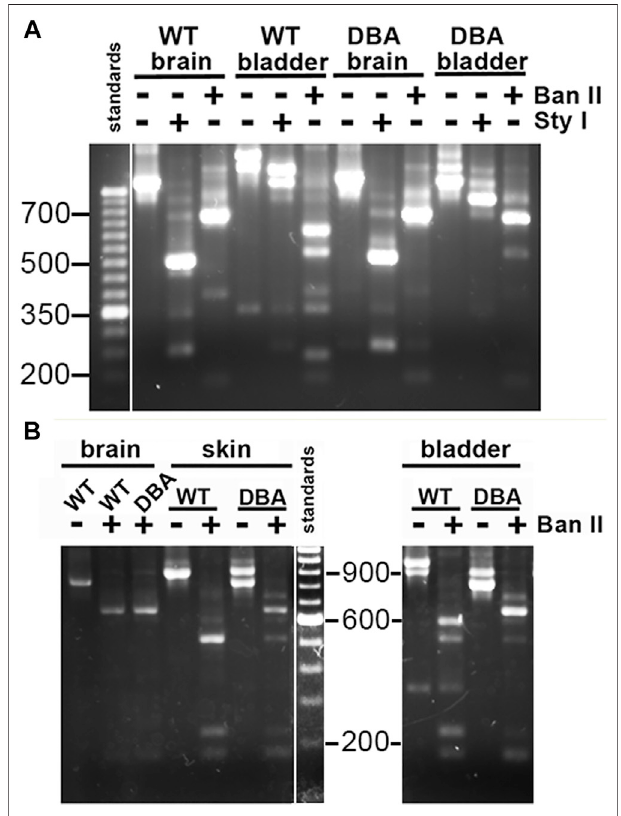
FIGURE 5 | Myo5a splice variants in tissues of WT and DBA mice. (A) Illustration of differential Myo5a variant expression pattern in detrusor and brain from WT and DBA mice. Nested PCR fragments of brain and detrusor cDNAsfromaWTandaDBAmousepairwerepreparedwithprimerpair 2, then compared by agarose gel electrophoresis either undigested or digested with Sty I or Ban II, as shown above the lanes. A 50 base pair (bp) ladder with weighted 350 bp standard is at left. Contrast was adjusted separately for the standard lane, to bring out the positions of the smaller standards. (B) NestedPCRfragmentspreparedfrombrain,skin,anddetrusor of a WT and DBA mouse with primer pair 2, were compared before and after digestion with Ban II. A100 bp ladder with weighted 600 bp standard is shown and contrast was adjusted separately. All lanes were from a single gel; those for detrusor PCRs and digests were moved to the right, so that sizes of the standard fragments could be added.